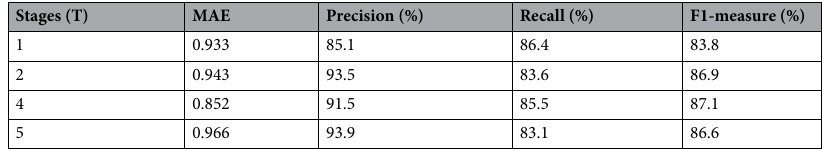
Table 1. Influence of the number of stages (T) in counting and detection of M. flexuosa palms-trees ( σ min = 1 and σ max = 4 were adopted).